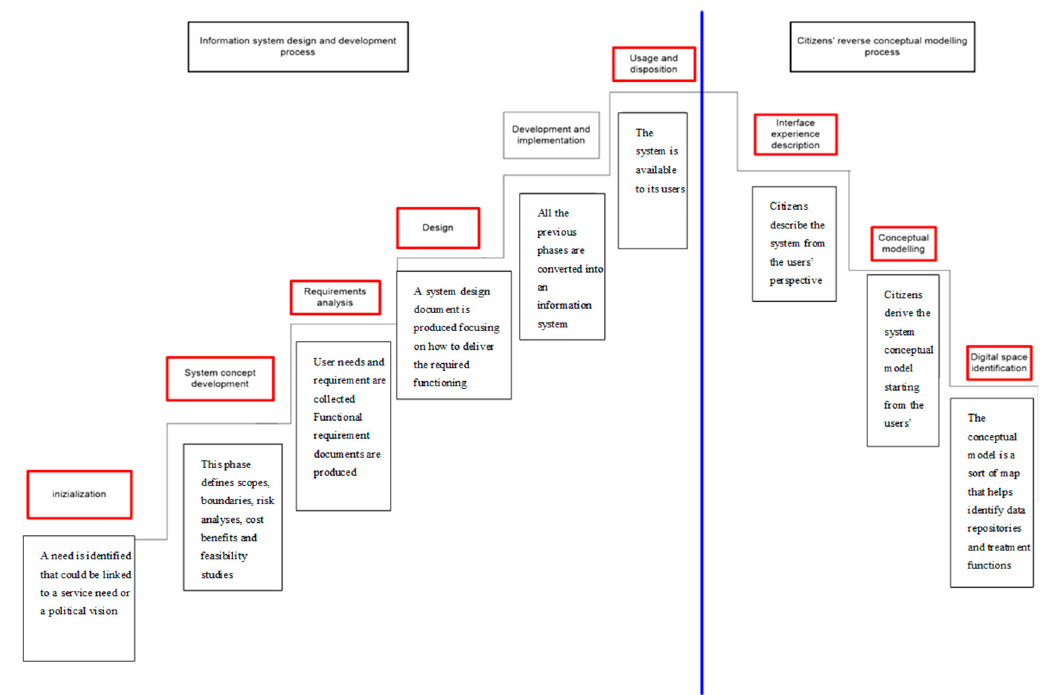
Figure 3. Citizens’ reverse conceptual modeling process. Table 1. Role of citizens.